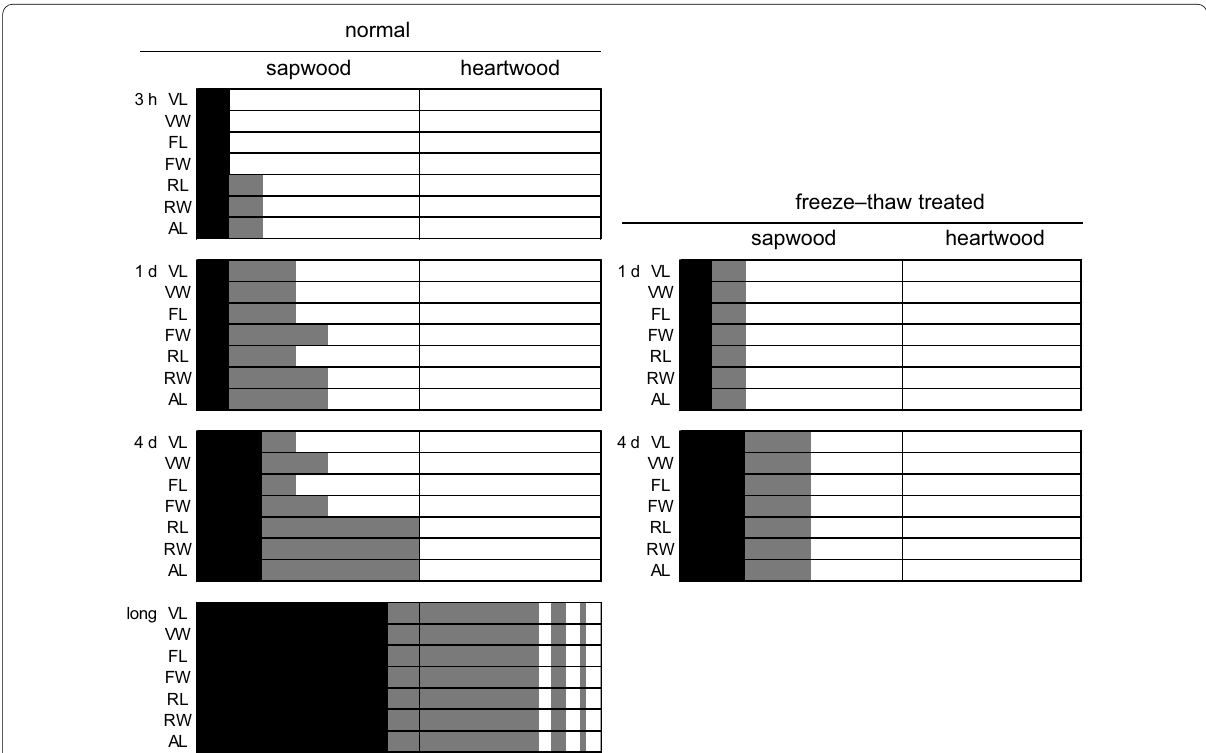
Fig. 7 Schematic representation of the radial distribution of Cs after injection into the outer sapwood of konara oak ( Quercus serrata ). Black and gray fields denote areas where Cs was detected. Black fields represent the red region stained by acid fuchsin. For abbreviations, please refer to Fig.